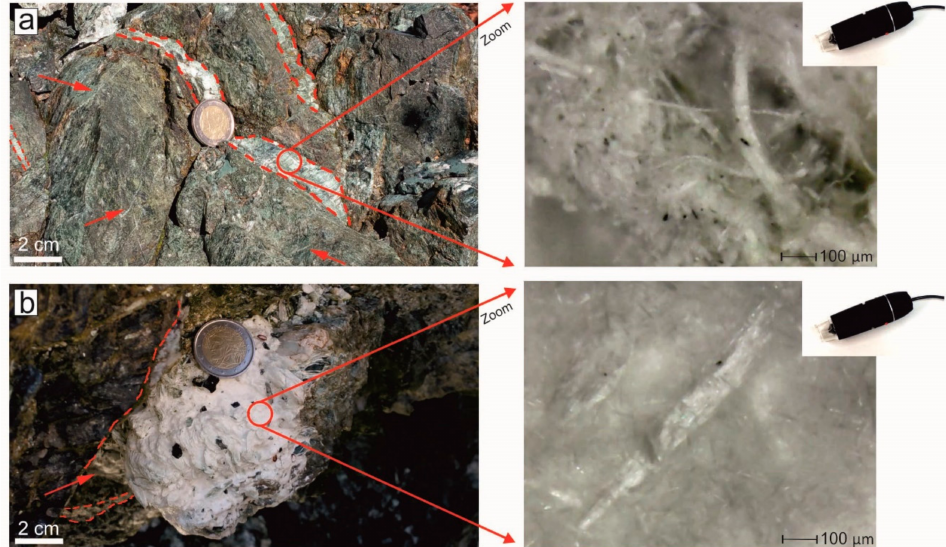
Figure 3. ( a ) Veins network developing inside massive serpentinite, note the arrangement of elastic fibers inside the veins, ( b ) asbestos tremolite in outcrop at the mesoscale, note as tremolite appear straight, poorly flexible and exhibit a needle-like crystal habit. Veins indicated by arrow and dotted red